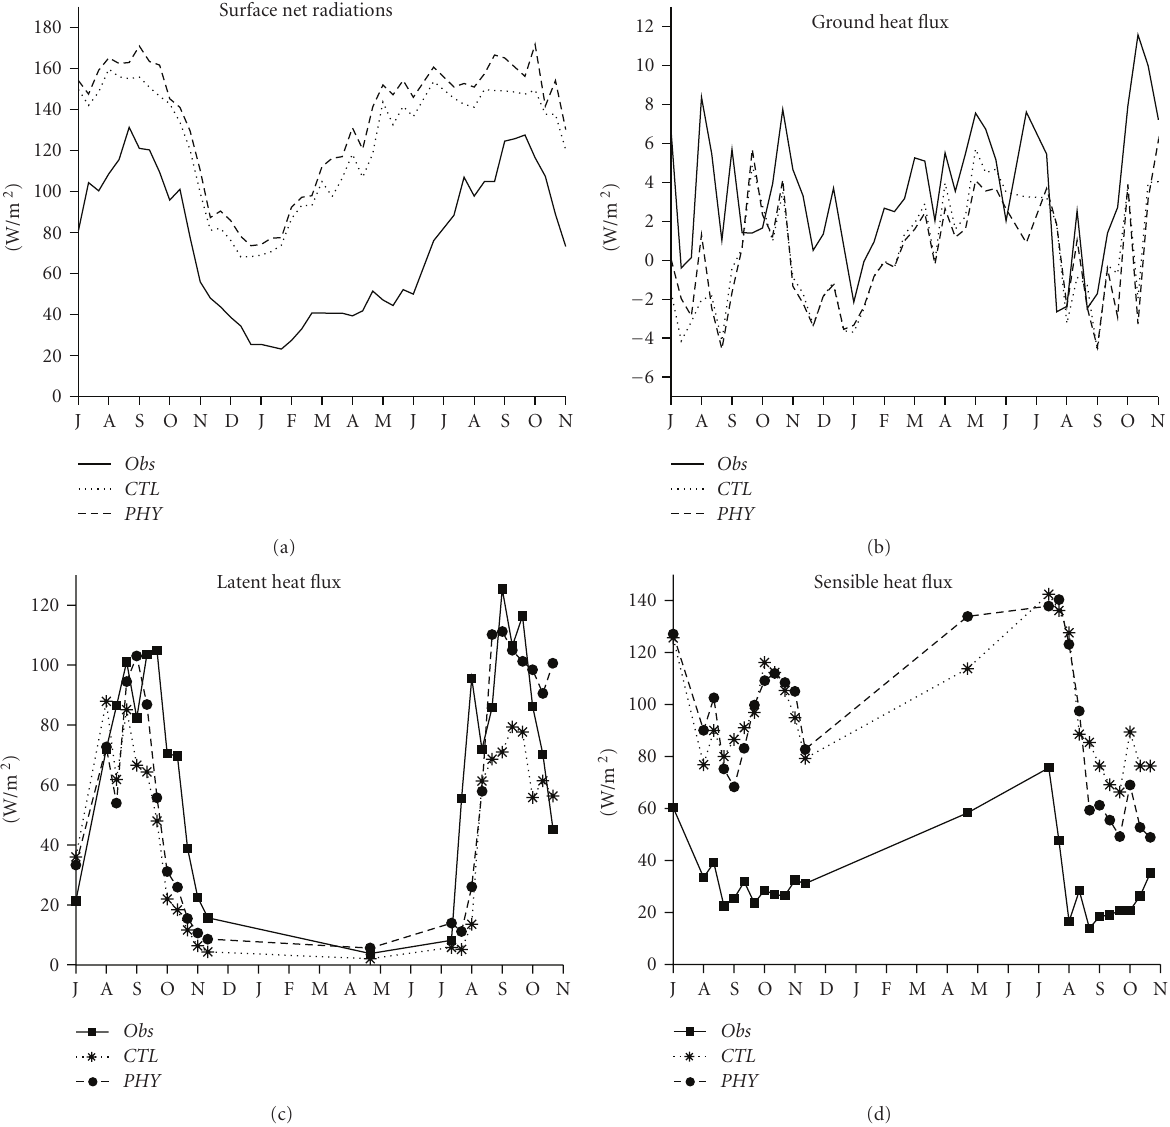
Figure 8: As in Figure 7 but for land surface energy budget variables averaged over a 10-day period. All related statistics are given in Table 2. Note that for the latent and sensible heat fluxes, each period were there is not enough day of observation ( < 5 days) to perform an average have been